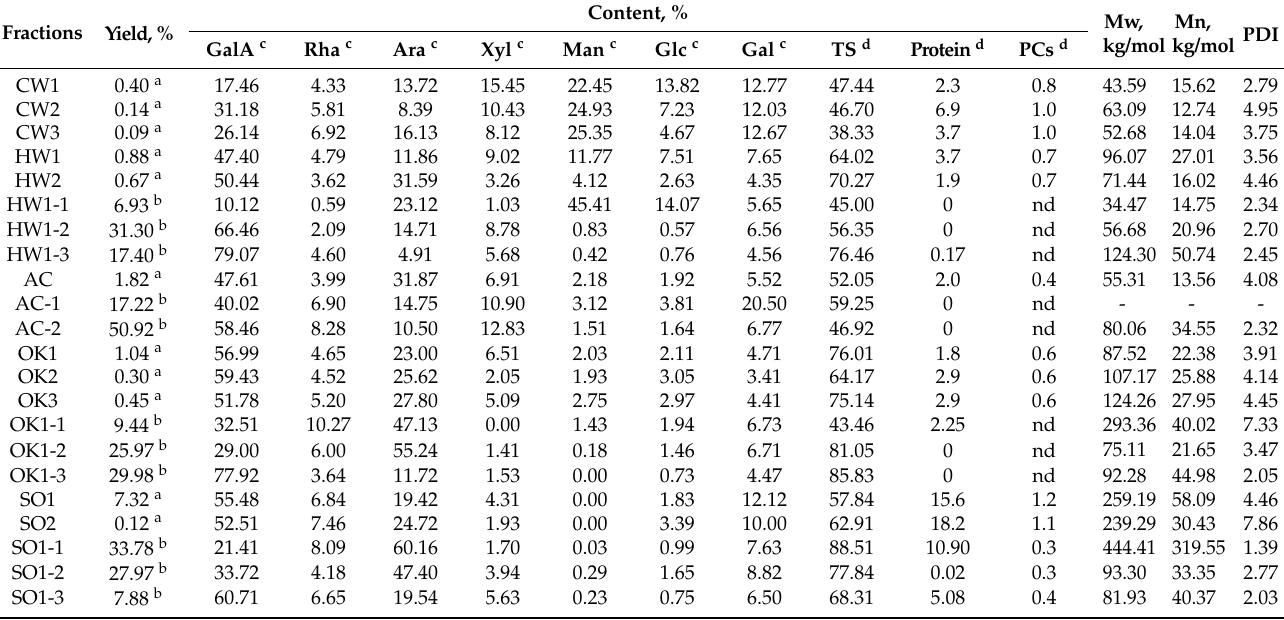
Table 1. Chemical characteristics of pectic polysaccharides from the S. passerine .